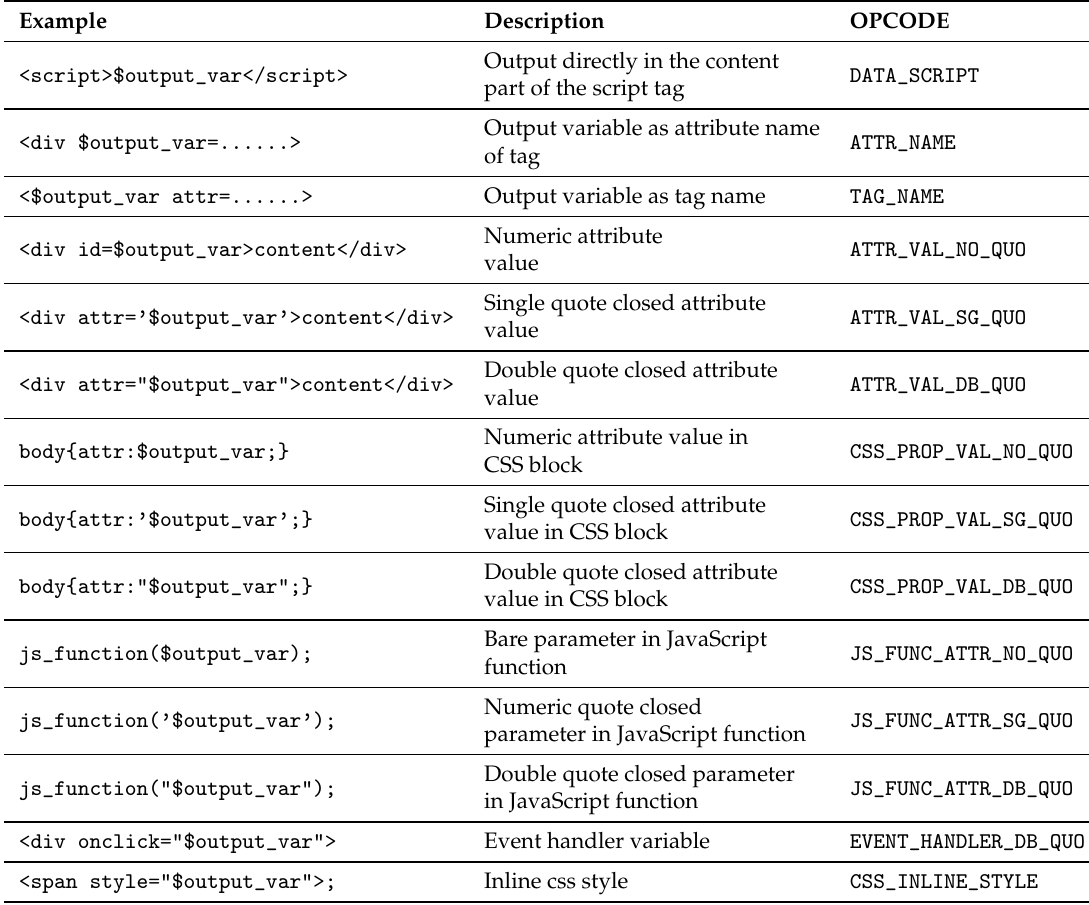
Table 3. Kinds of